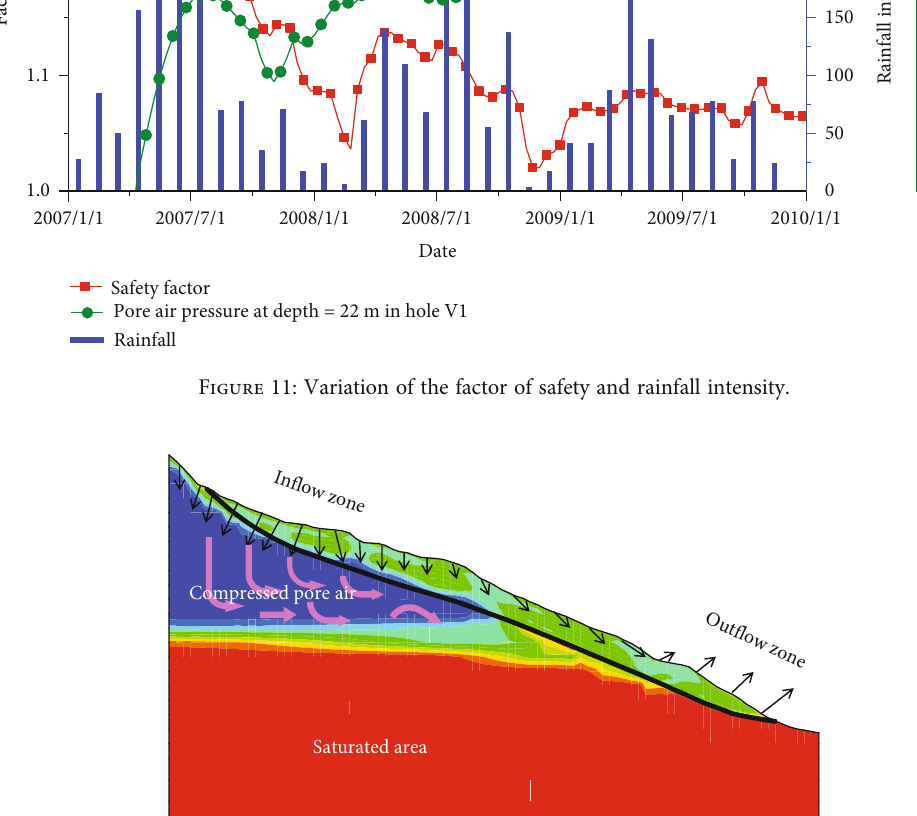
Figure 12: Schematic diagram of the air fl ow e ff ect on slope stability.